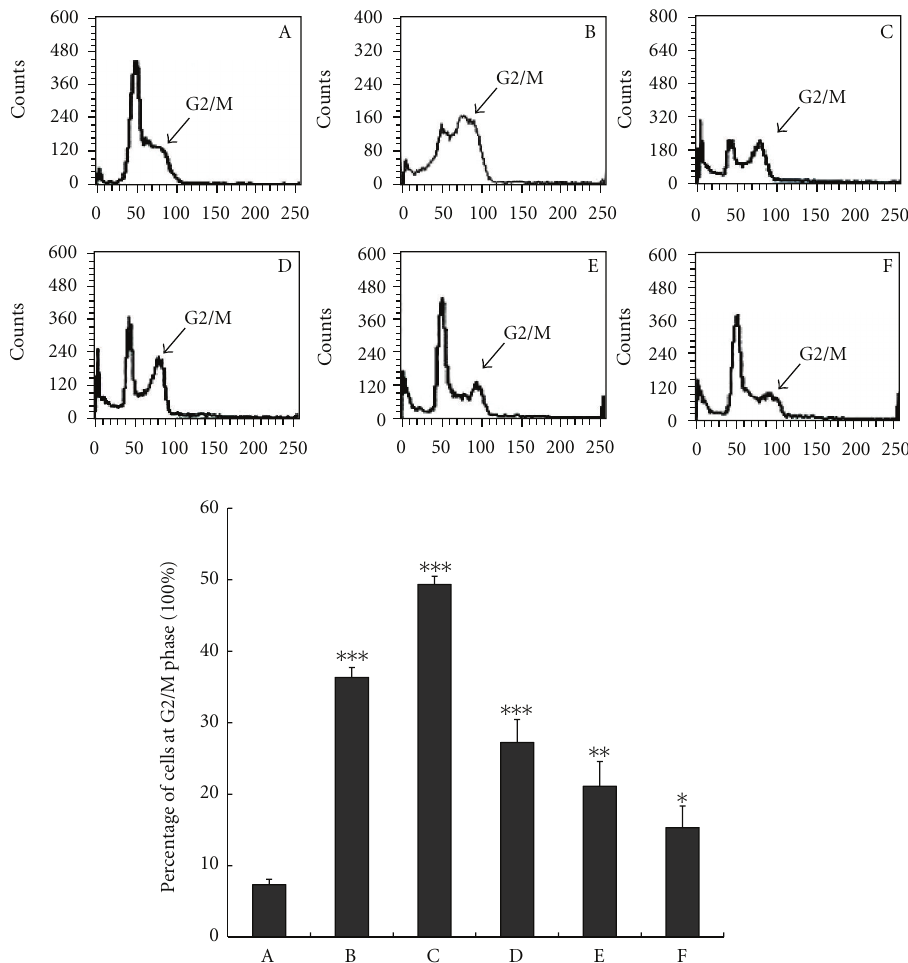
Figure 6: Van-7 arrested A549 cell line at G2/M phase. A: control; B: HCPT, 40 μ M; C: Van-7, 100 μ M; D: Van-7, 50 μ M; E: Van-7, 25 μ M; F: Van-7, 12.5 μ M. The percentage of G2/M, A: 7.32%; B: 36.32%; C: 49.36%; D: 27.21%; E: 21.10%; F: 15.31%. The values were the means ± SD, n = 3. ∗ P < 0 . 05, ∗∗ P < 0 . 01, ∗∗∗ P < 0 . 001 versus control